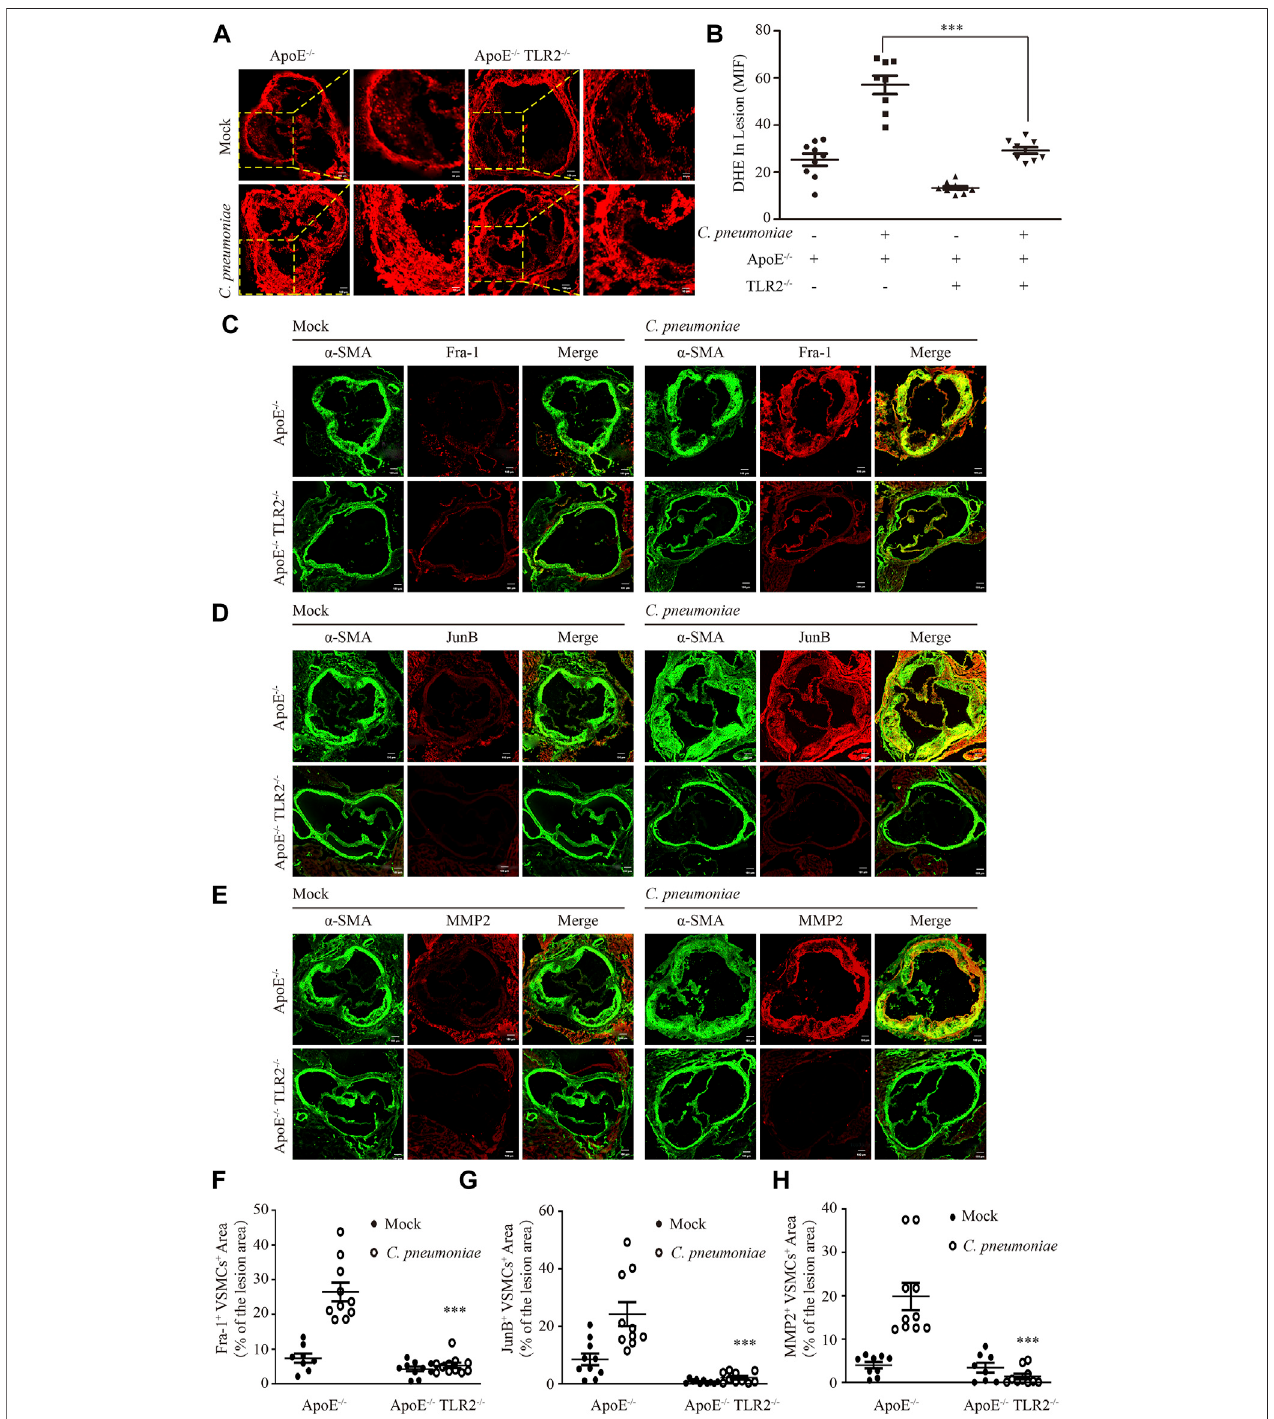
FIGURE 8 | TLR2 regulates the expression of Fra-1, JunB and MMP2 in VSMCs after C. pneumoniae infection in vivo . (A) The ROS level was assessed by DHE in the lesions of aortic sinus from ApoE -/- and ApoE -/- TLR2 -/- mice fed a Western diet for 6 weeks with or without C. pneumoniae infection. n = 8 – 11. Scale bar: 100 μ M (Left), 50 μ M (Right). (B) Quanti fi cation of DHE fl uorescence intensity in the lesions of aortic sinus from ApoE -/- and ApoE -/- TLR2 -/- mice fed a Western diet for 6 weeks with or without C. pneumoniae infection. *** p < 0.001, compared with C. pneumoniae -infected ApoE -/- mice groups, as analyzed by Student ’ s t -test. (C – E) The expression of Fra-1 (C) or JunB (D) or MMP2 (E) in VSMCs in atherosclerotic lesions of ApoE -/- and ApoE -/- TLR2 -/- mice fed a Western diet for 6 weeks with or without C. pneumoniae infection. Scale bar: 100 μ M. (F – H) Quanti fi cation of active Fra-1 + (F) , JunB + (G) and MMP2 + (H) VSMCs in the lesions of aortic sinus from ApoE -/- and ApoE -/- TLR2 -/- mice fedaWesterndietfor 6 weeks withor without C. pneumoniae infection. *** p < 0.001,comparedwith C.pneumoniae -infected ApoE -/- mice groups, as analyzed by Student ’ s t -test.